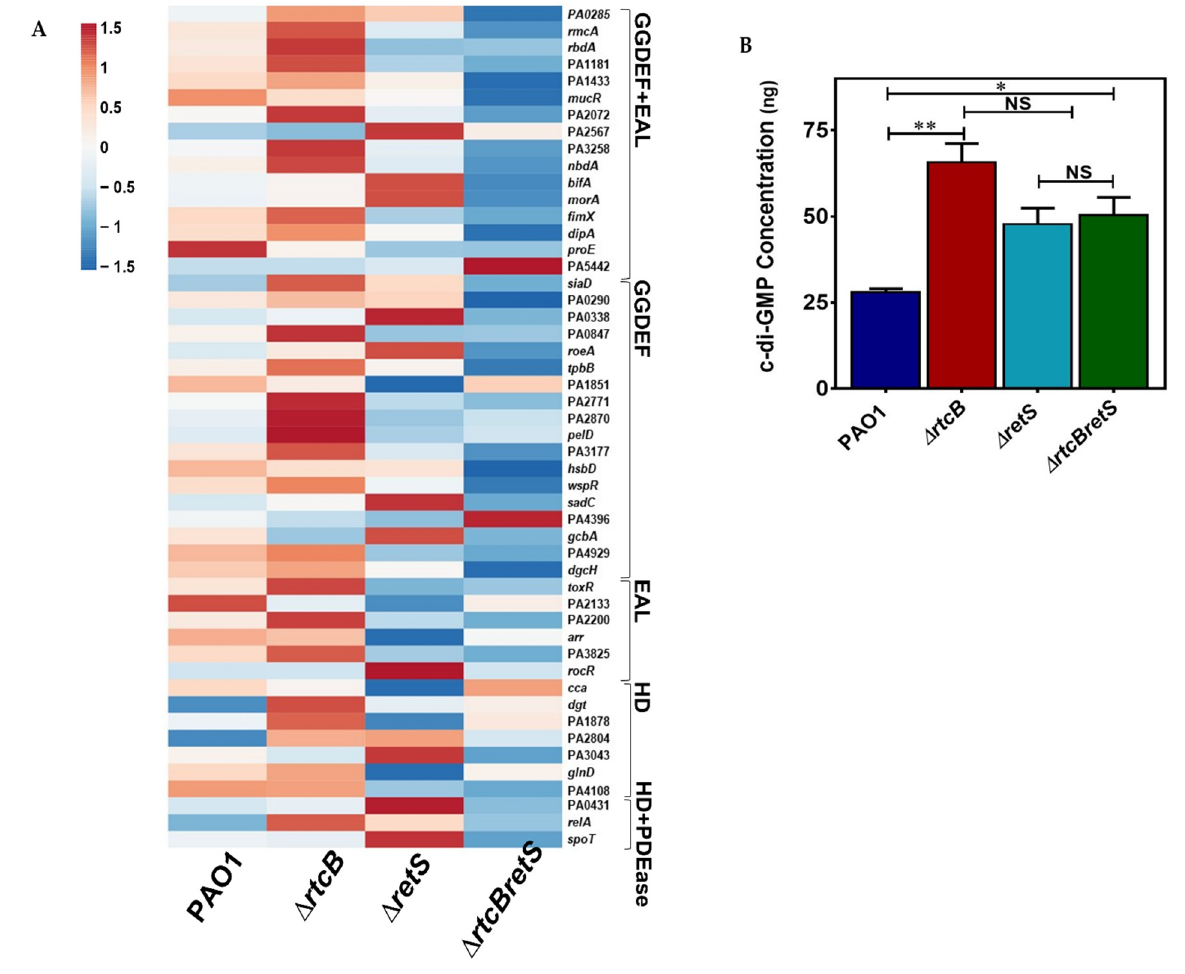
Figure 8. Comparison of c-di-GMP-related transcriptome and intracellular c-di-GMP concentration in PAO1, PAO1( ∆ rtcB ), PAO1( ∆ retS ), and PAO1( ∆ rtcB ∆ retS ) strains. ( A ) The transcription levels of genes involved in c-di-GMP secondary messenger metabolism were calculated from FPKM values using the MATLAB graphical toolbox and represented as color-coded boxes (blue, downregulation; red-code, upregulation). ( B ) Deletion of rtcB significantly increased the intracellular concentration of c-di-GMP (PAO1 vs. PAO1( ∆ rtcB )), indicating an important role of rtcB in the modulation of c-di-GMP metabolism. Data were analyzed using one-way ANOVA with Dunnette post-hoc test, NS p > 0.05, * p < 0.05, ** p < 0.01.